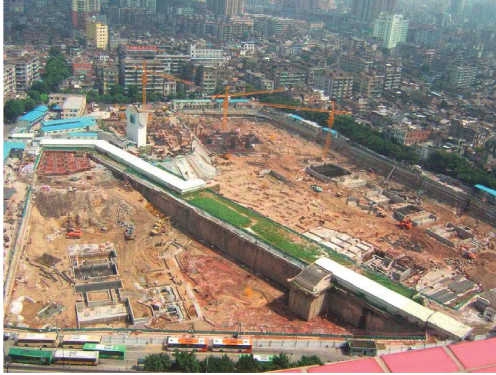
Figure 4: Full view of the